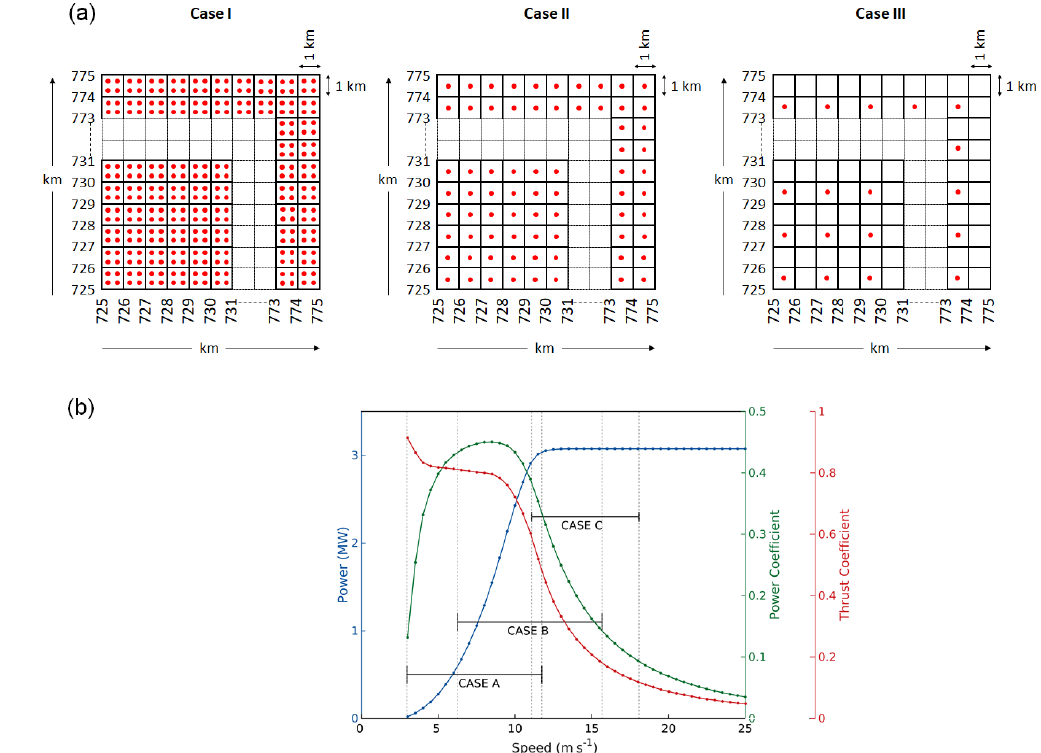
Figure 2. (a) Wind farm layouts for case I, case II, and case III with inter-turbine distance of 0.5, 1, and 2km, where the red dots represent the wind turbines. (b) Power curve (blue), power coefficient (green), and thrust coefficient (red) of 3.075MW Vestas turbine as a function of wind speed. The horizontal bars represent the wind speed ranges during the three cases (A, B, and C)